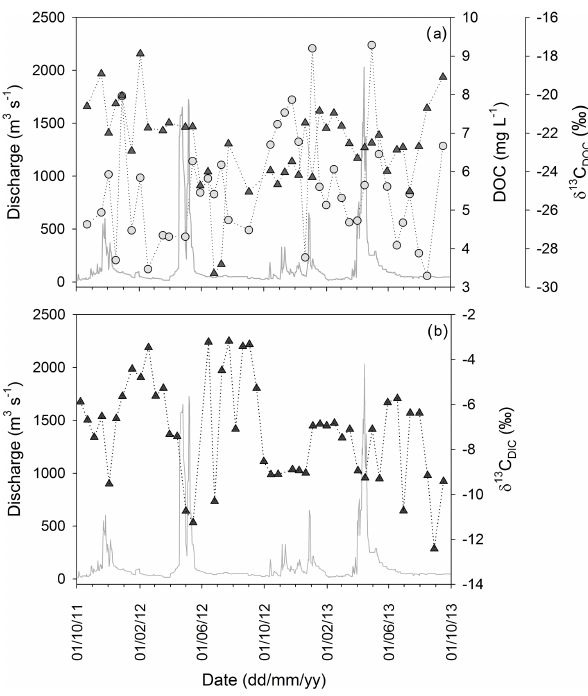
Figure 5. Discharge and 2 years of monitoring the dissolved (a) or- ganic carbon concentration and carbon stable isotope signature, and (b) the carbon stable isotope signature of dissolved inorganic car- bon in the Sabaki River. Grey circles represent bulk concentrations, with dark triangles for all stable isotope